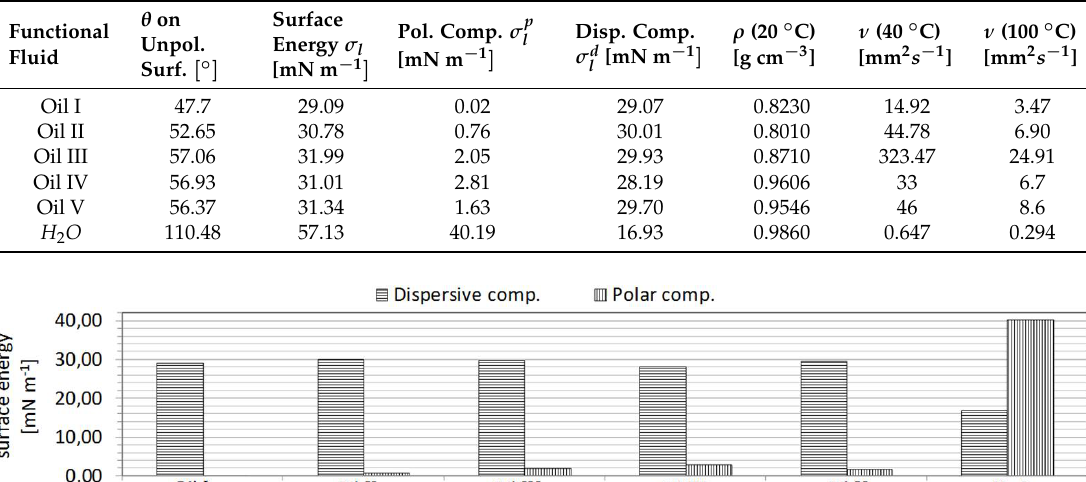
Table 4. Physical properties of the functional fluids.